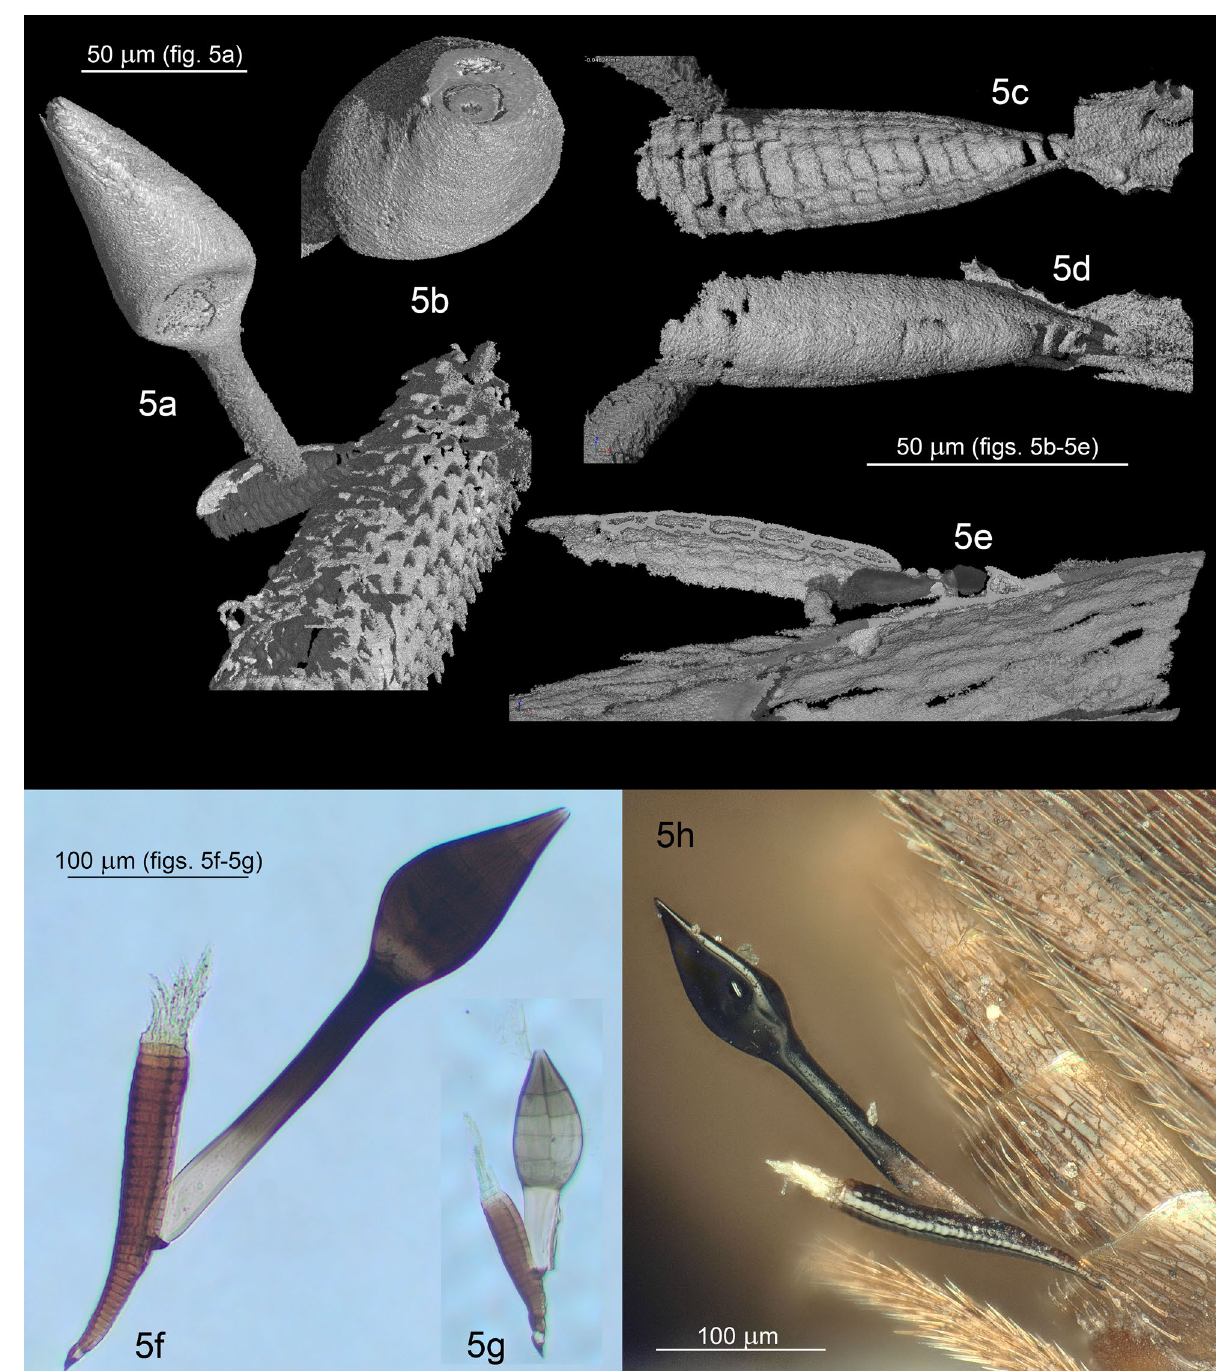
Figure 5. Genus Columnomyces . ( a ) † C. electri sp. nov., mature thallus. ( b ) † C. electri , perithecium, with transversal cut at the apex showing the two apical cells. ( c ) † C. electri , receptacle, internal side. ( d ) † C. electri , receptacle, external side. ( e ) † C. electri , receptacle transversal cut. ( f ) C. peckii sp. nov., mature thallus. ( g ) C. hispaniolensis sp. nov., mature thallus. ( h ) C. peckii , mature thallus attached to its host’s sternite ( in-situ